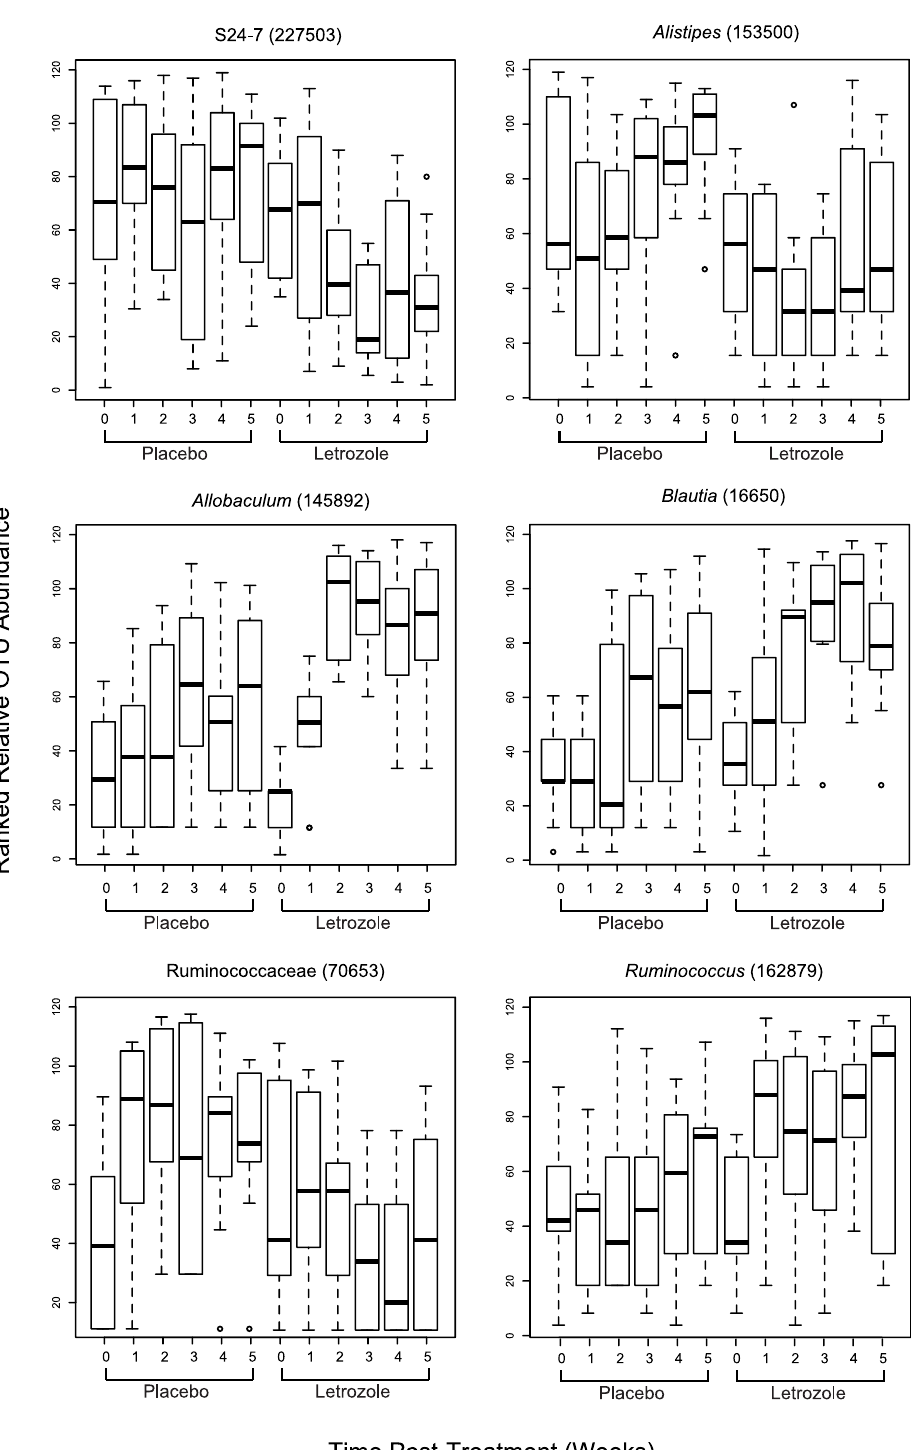
Fig 6. Time-dependent response to letrozole treatment varies among bacterial species. Box and whisker plots showing average ranked abundances of 6 OTUs at each collection time for placebo and letrozole treated mice, as